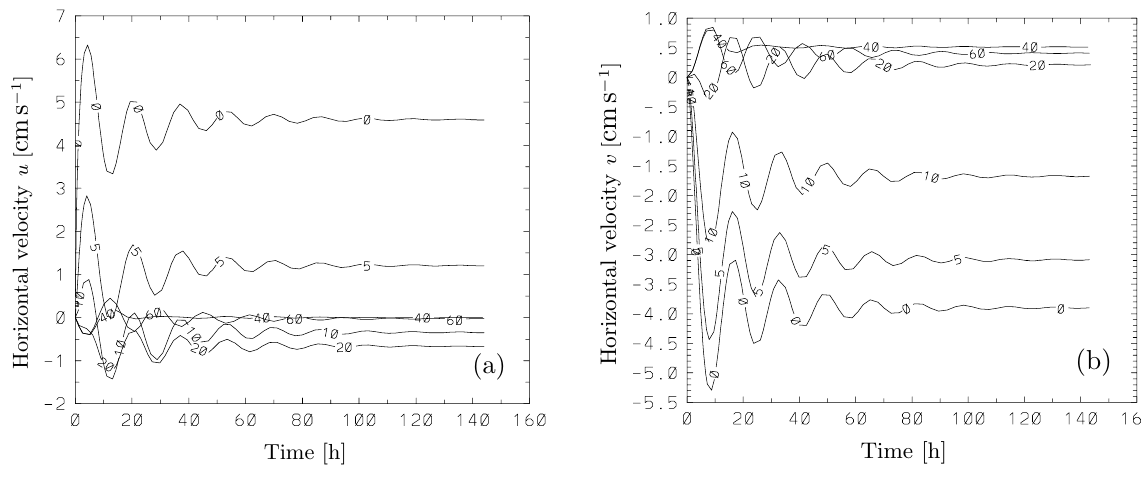
FIG. 3: Time series of the horizontal velocity components u (a) and v (b) in the rectangular basin subject to constant wind from West computed with constant vertical eddy viscosity ν v = 0 . 005m 2 s − 1 . The labels on curves stand for depth in meters.